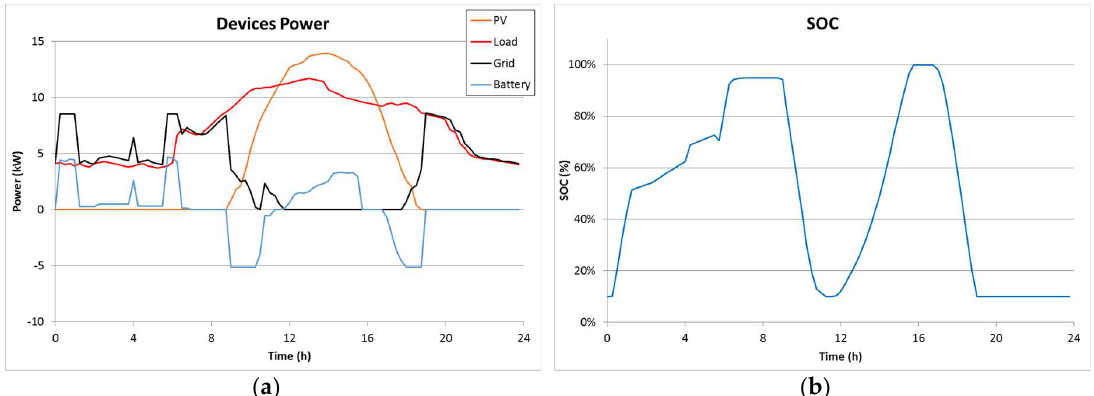
Figure 7. Real hardware tests. ( a ) Devices power. Battery and load power are considered positive when received. Grid and PV power are considered positive when delivered. ( b ) Battery state of charge (SOC).